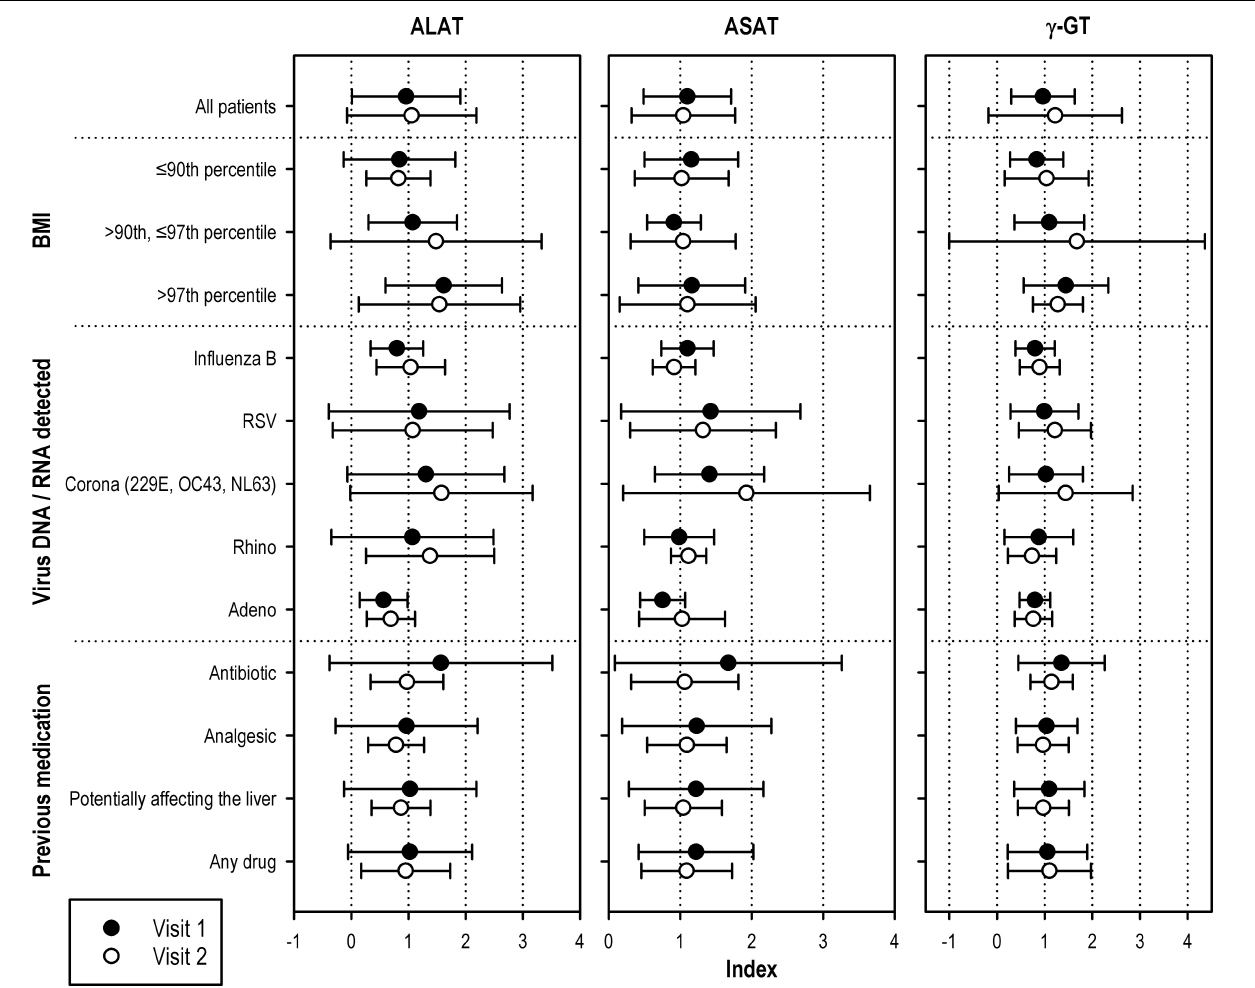
FIGURE 2 | ALAT index ASAT index, and γ -GT index of patients with at least one elevated serum liver enzyme activity at visit 1 or visit 2 (means ± standard deviations). Only subgroups with at least five patients at visit 2 are displayed. Laboratory values were normalized by dividing by the upper limit of the normal range (ULN). The resulting index ( < 1, below ULN; > 1, above ULN) allowed to compare results from laboratories with different reference